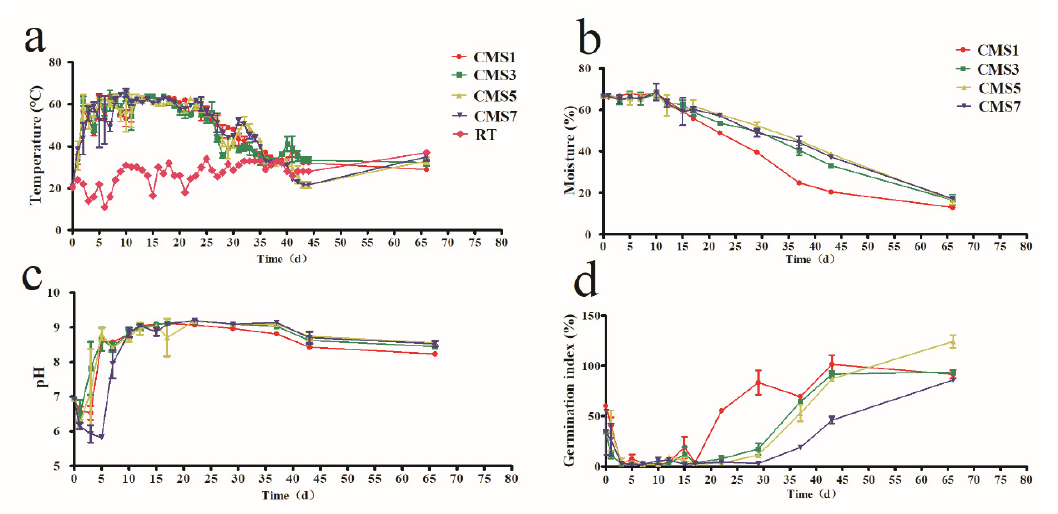
Figure 1. Changes in temperature ( a ), moisture ( b ), pH ( c ) and germination index ( d ) at different treatments during the composting. Every data point represents the mean of three replicates. Bars indicate the SDs of the means.